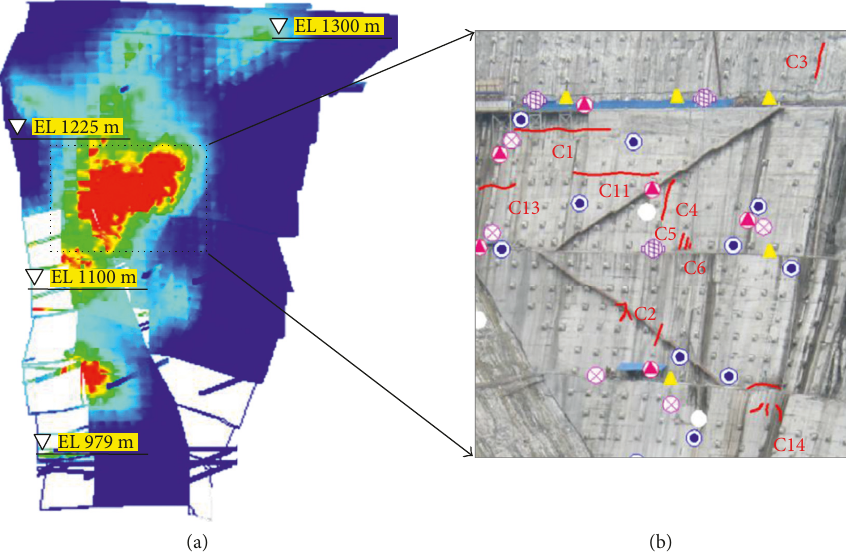
Figure 10: (a): Excavation-induced seismic deformation on the slope surface and (b) on-site photograph of the cracked region on the slope surface after excavation between elevations of 1,100m and